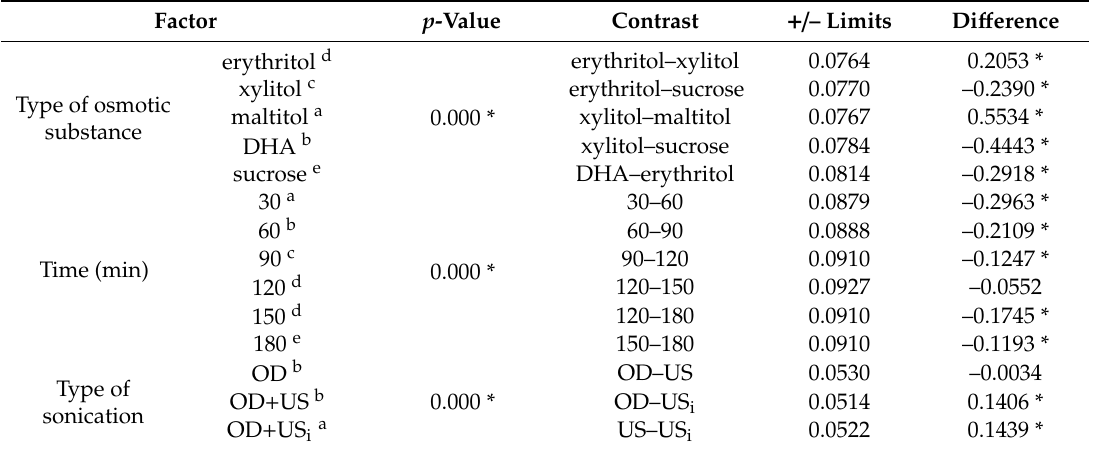
Table 3. The influence of osmotic agents and pre-treatment time on water loss during OD. Factor p